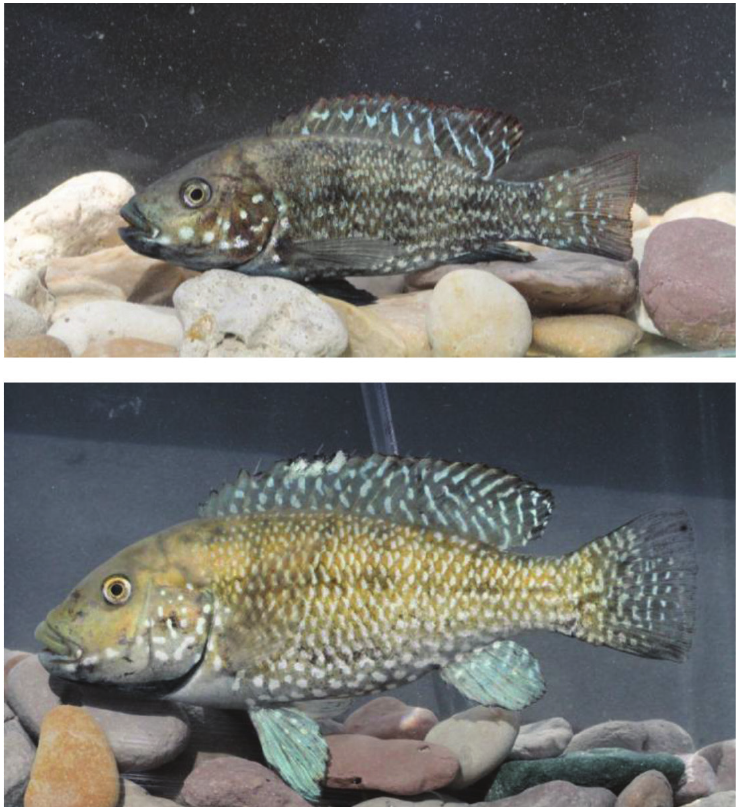
Figure 10. Iranocichla from Kol River drainage: ZM-CBSU IP25 male, 71.3 mm SL; Hormuzgan prov.: Faryab hot spring, Kol River drainage, ZM-CBSU-IP34 male, 112.9 mm SL; Hormuzgan prov.: Gode- Gaz Spring, Kol River